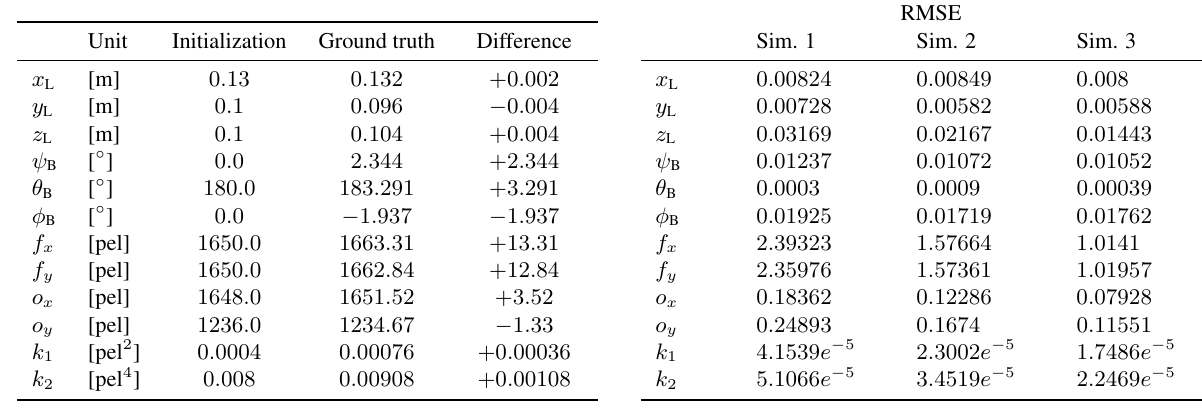
Table 1: This table states the initialization and ground truth values used in our experiments. For an easier interpretation the differ- ence between the values is also stated.